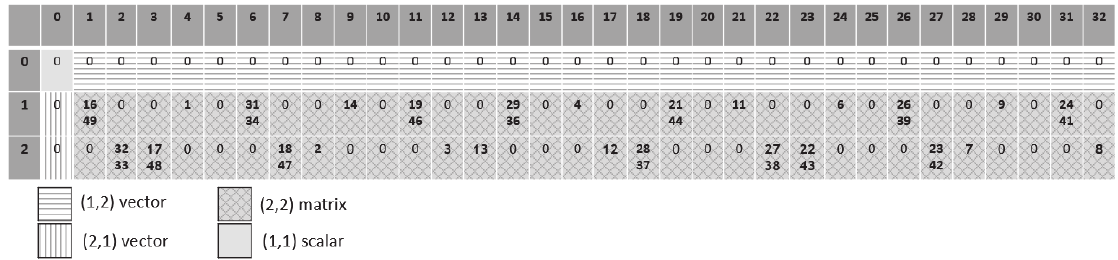
Figure 10. Space harmonics distribution in L sr (cid:4666)θ(cid:4667) for the five ‐ phase IM with 65 bars (in line 1, 13 αβ planes among 32 are excited. In line 2, 12 planes among 32 are excited. No zero-sequence is excited. This leads to less interactions than 64 bars).